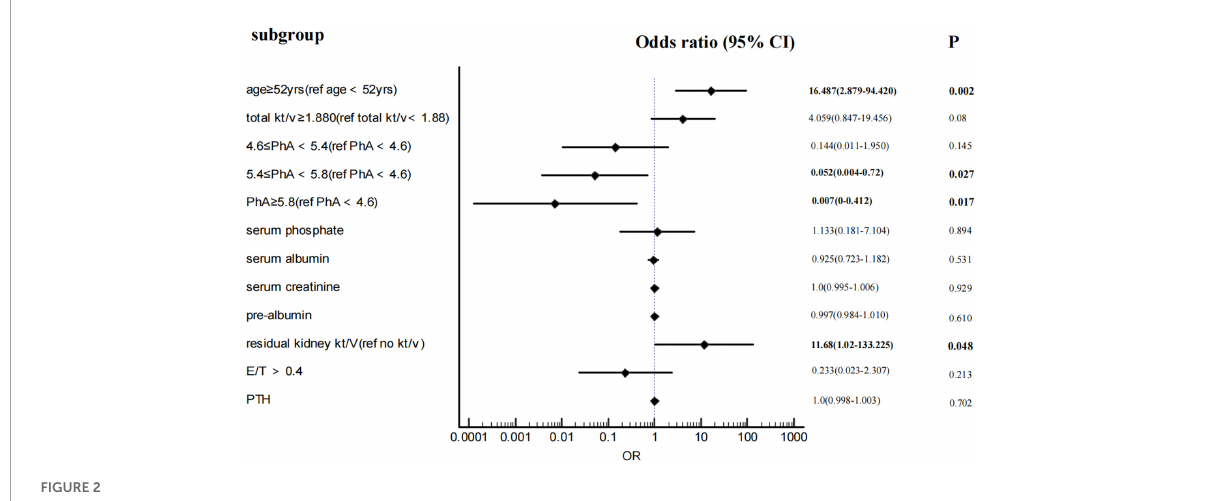
FIGURE2 Forest plot of binary logistic regression